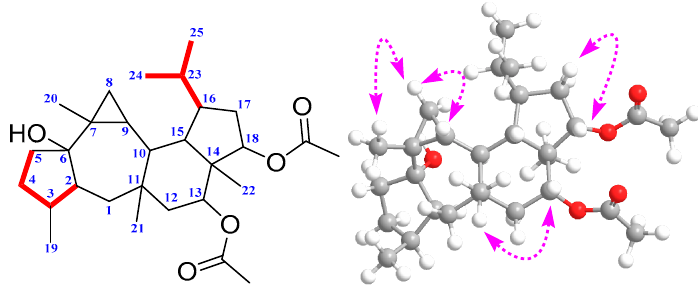
Figure 3. Selected HSQC-TOCSY (red bold) and ROESY correlations of 1 .